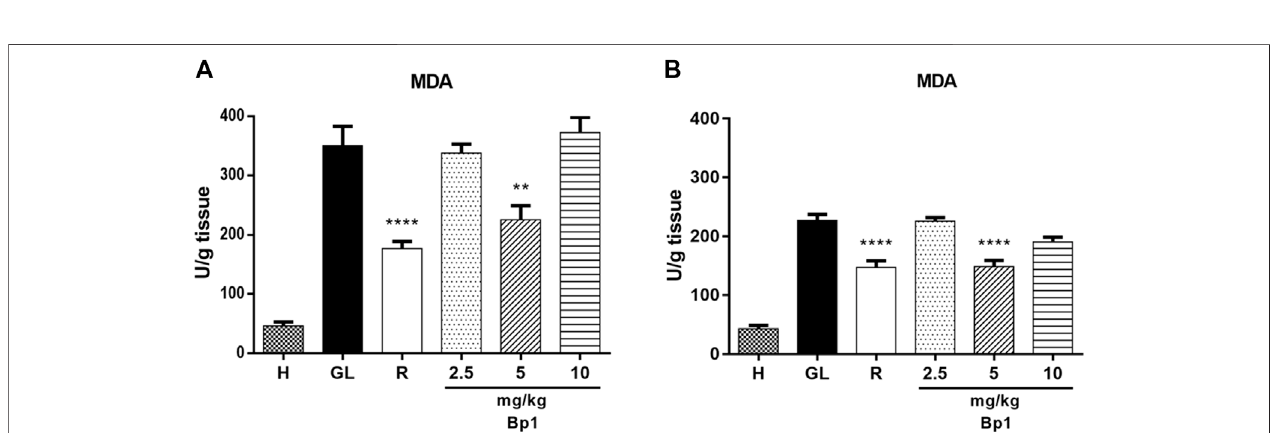
FIGURE 12 | Effect of pretreatment with Bp1 (2.5, 5, and 10 mg/kg) on MDA levels in the gastric mucosa homogenate of lesions in mice (A) ethanol-induced and (B) indomethacin-induced. Results expressed as mean ± standard mean error ( n (cid:2) 7). ANOVA and Tukey post-test were used to calculate the statistical signi fi cance, ** p < 0.01 and **** p < 0.0001 vs. gastric lesion control. Healthy, H; gastric lesion control, GL; ranitidine (50 mg/kg), R.